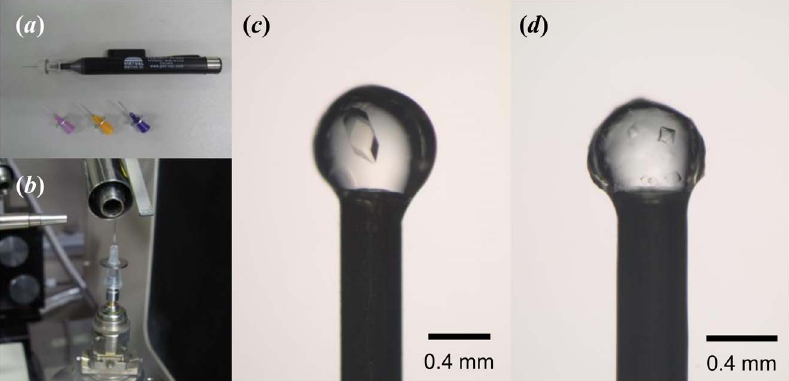
Figure 3. Photographs of tools for the gel-bead manipulation. (A) Vacuum tweezers and syringe-needle probes. (B) Syringe-needle probe with a gel bead mounted on the goniometer head of a diffractometer. (C) Alginate and (D) k -carrageenan gel beads attached to the tip of syringe- needle probes.